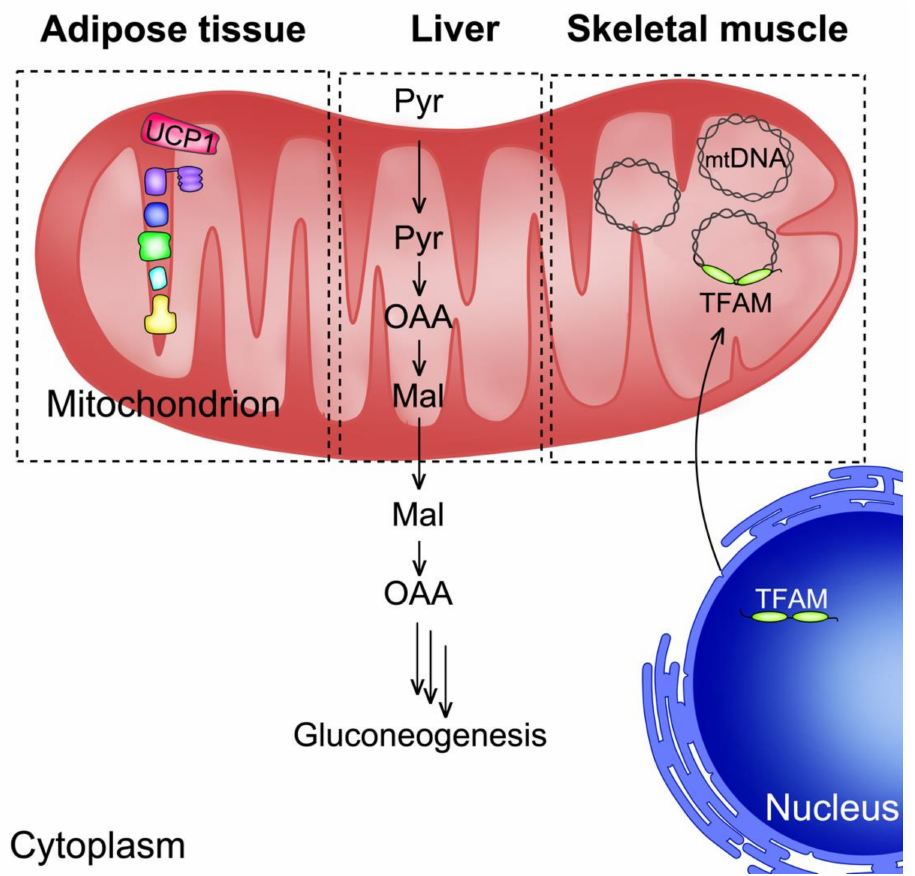
Figure 1. Roles of PGC1 α in different tissues. A schematic summary of the roles of PGC1 α in adipose tissue, liver and skeletal muscle discussed in this section is depicted. UCP1, uncoupling protein 1; Pyr, pyruvate; OAA, oxaloacetate; Mal, malate; mtDNA, mitochondrial DNA; TFAM, mitochondrial transcription factor